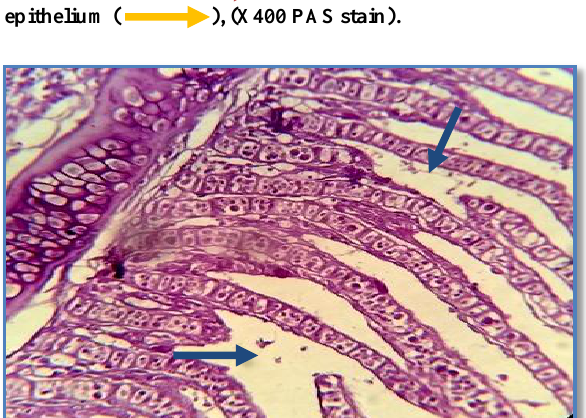
Figure, 2: Longitudinal section of filament during winter season showing damage of secondary lamellae ( ), (X400 H and E stain).